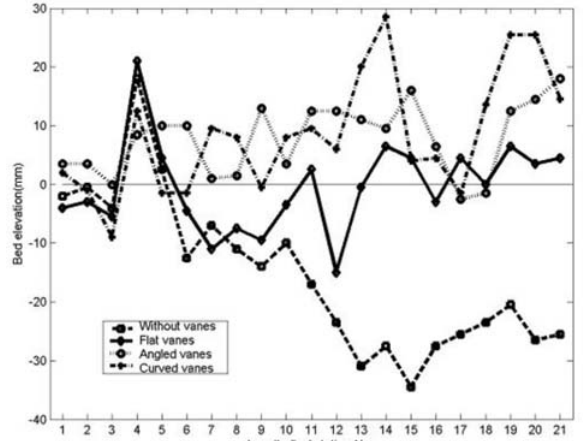
Fig. 10. Longitudinal bed profiles 3-cm from outer bank of 3- vanes in a row in parallel pattern on